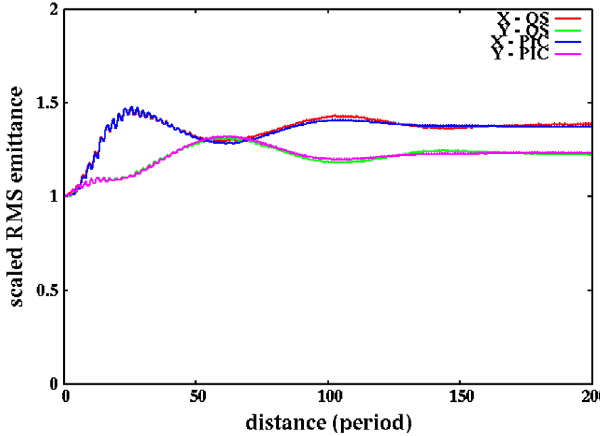
FIG. 7. Horizontal (x) and vertical (y) rms emittance evolution through a five period FODO lattice from the quantum Schrö- dinger method (red and green) and from the PIC method (blue and magenta) with the mismatched space-charge